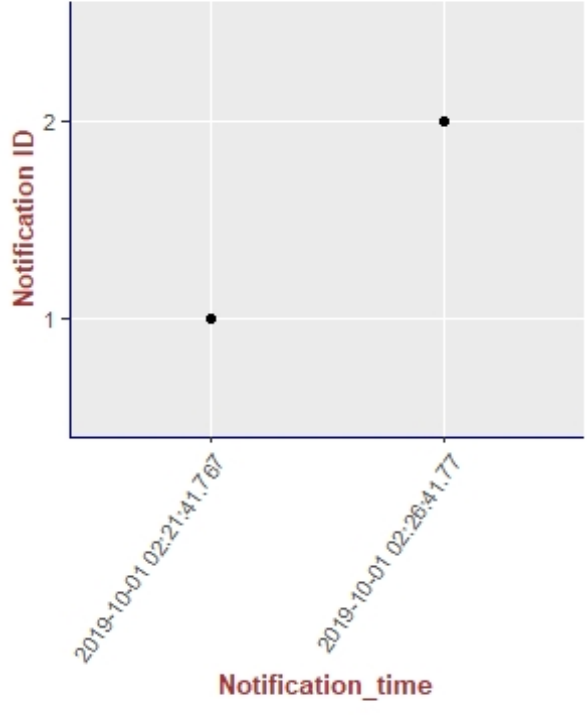
Figure 18. Illustration of the results of the delivery process related to all our